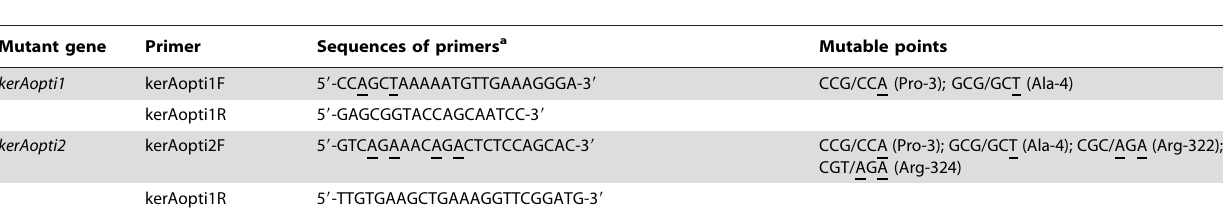
Table 1. The primers and site-directed mutable points of mutant keratinase genes.